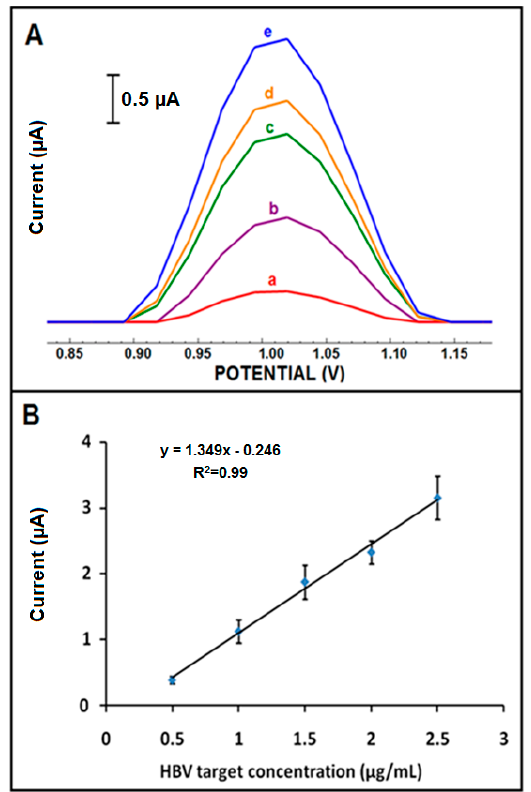
Figure 6. ( A ) DPVs represent the average guanine oxidation signals (n = 3) after hybridization be- tween amino linked HBV probe and (a) 0.5, (b) 1, (c) 1.5, (d) 2, and (e) 2.5 µg/mL HBV target onto the surface of CoPc-IL-PGE (n = 3). ( B ) Calibration plot obtained from oxidation signals of guanine after hybridization of amino linked HBV probe with different concentrations of HBV target at the surface of